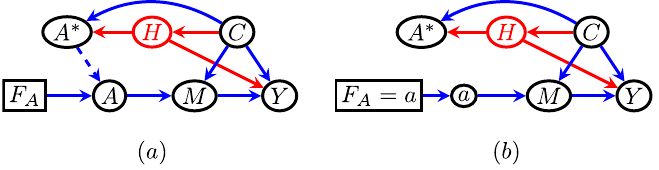
Figure 1: ( a ) The front - door model graph represented in the decision - theoretic framework. The dashed edge represents a context - speci fi c relation between the intention to treat version of the treatment ( A ∗ ) and the treatment itself ( A ) . This rela - tionship disappears if F ∅ A ≠ . ( b ) The edge subgraph of ( a ) showing context - speci fi c independences that occur when F ∅ A ≠